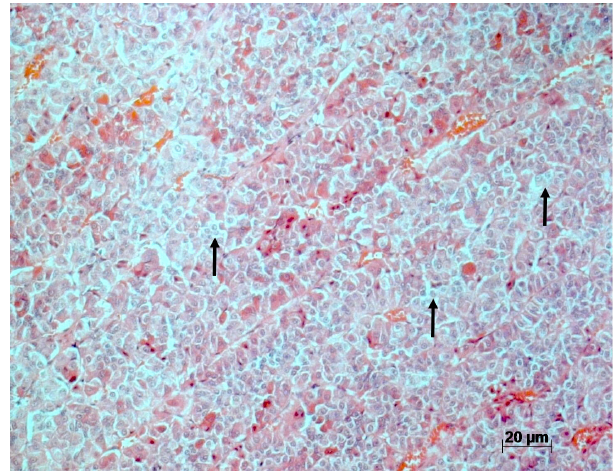
Figure 4. H&E stain of the adenohypophysis of rhesus macaques with chronic lymphocytic thyroiditis. Increased amount of large ba- sophilic cells